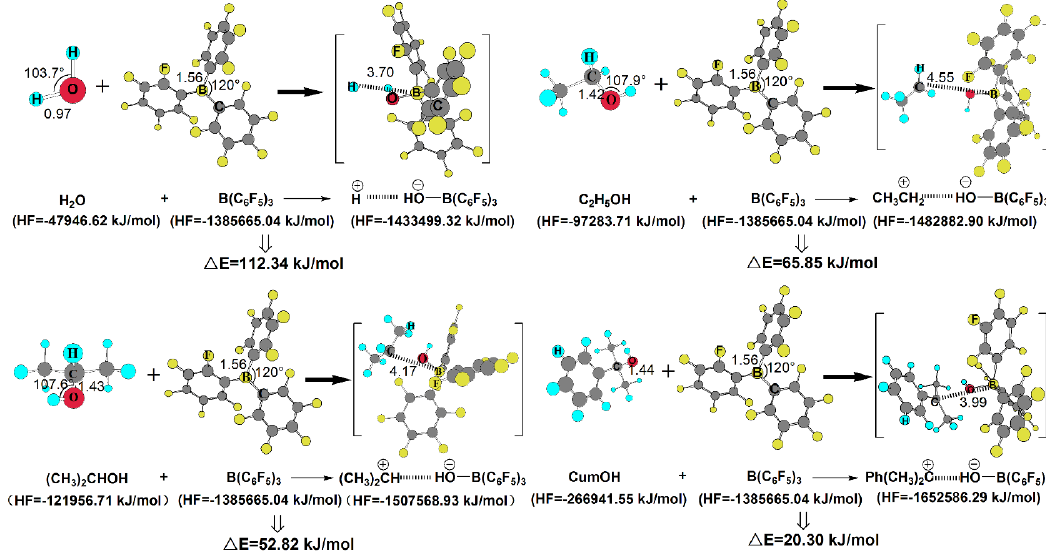
Figure 9. The optimized conformations of H + –B(C 6 F 5 ) 3 –OH − , CH 3 CH 2+ –B(C 6 F 5 ) 3 –OH − , (CH 3 ) 2 CH + –B(C 6 F 5 ) 3 –OH − and (CH 3 ) 2 C(C 6 H 5 ) + –B(C 6 F 5 ) 3 –OH − at the 6-31G*